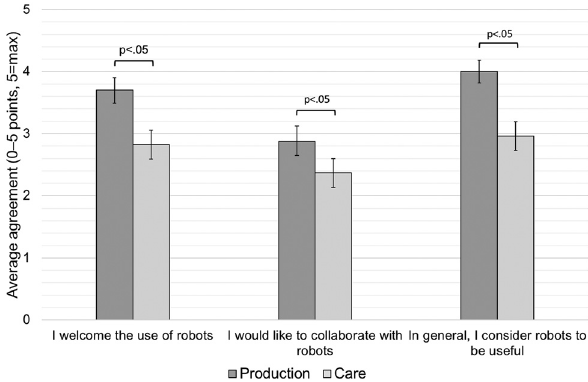
Figure 5: Intention to use robots in production vs care ( mean values with 95% con fi dence interval )